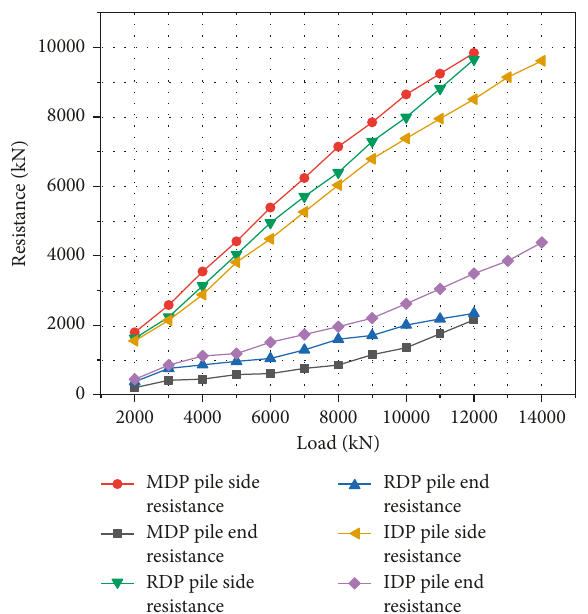
Figure 18: Test piles under different loads.